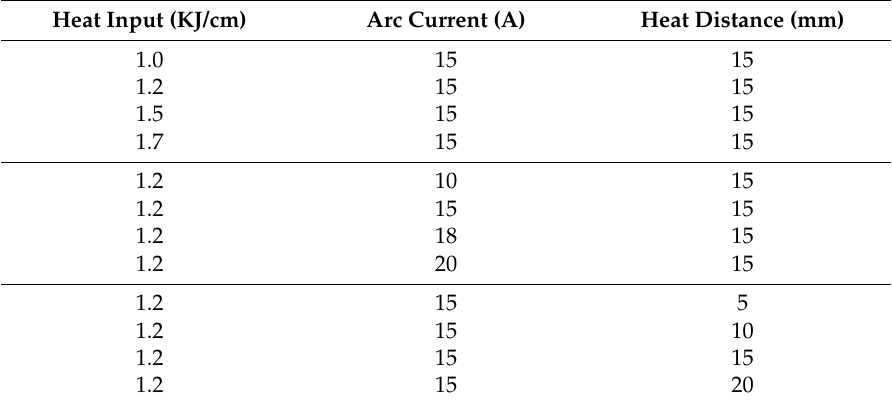
Table 3. The main parameters of arc assisted laser welding-brazing.